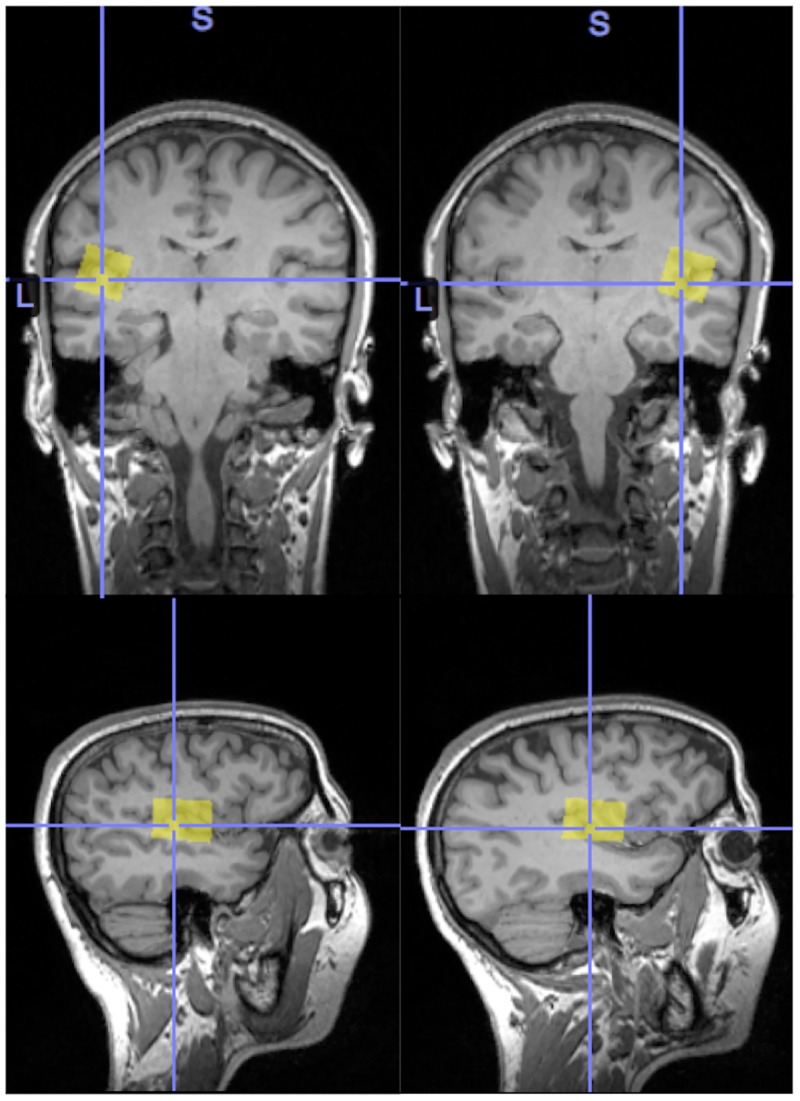
Example temporal lobe 1H-MRS voxel placement.Example participant left (left panel) and right (right panel) superior temporal lobe voxel placement.